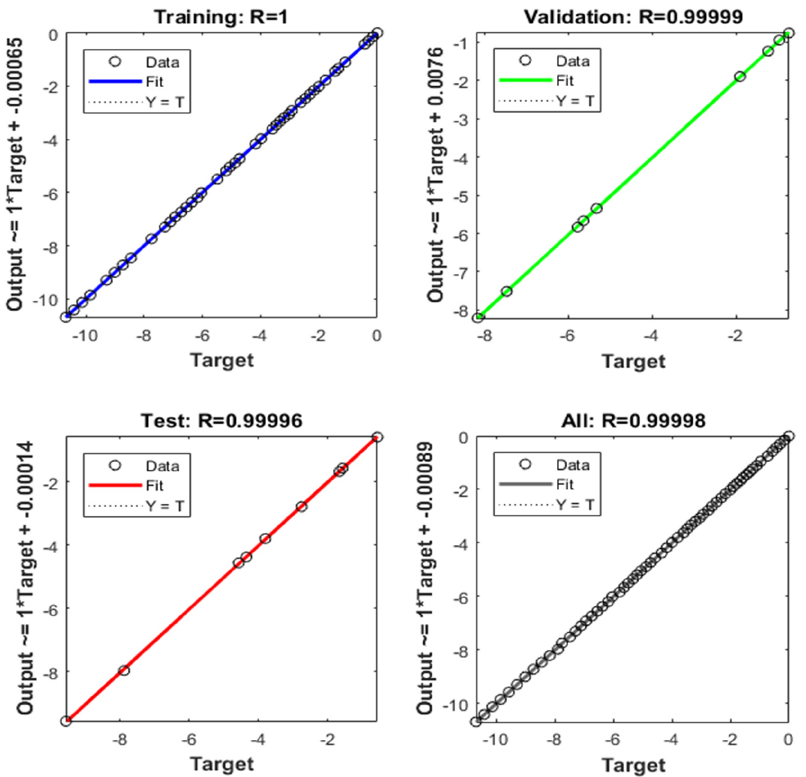
Figure 11. Prediction of the load vs. displacement relationship using ANN and using experimental observation for the training, validation, testing, and all datasets (BRC-4).